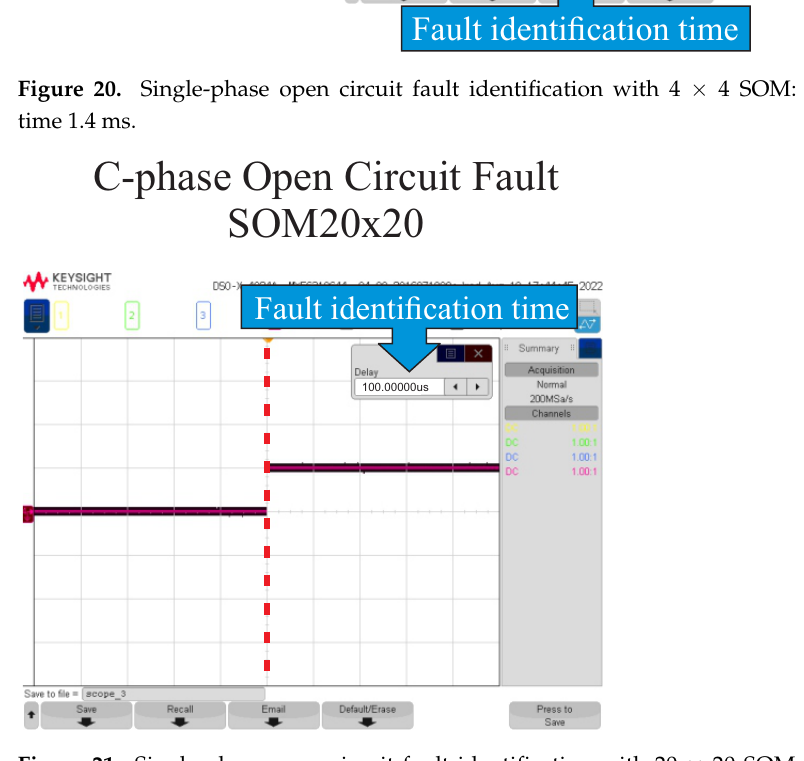
Figure 21. Single-phase open circuit fault identification with 20 × 20 SOM: Phase C; detection time 100 µ